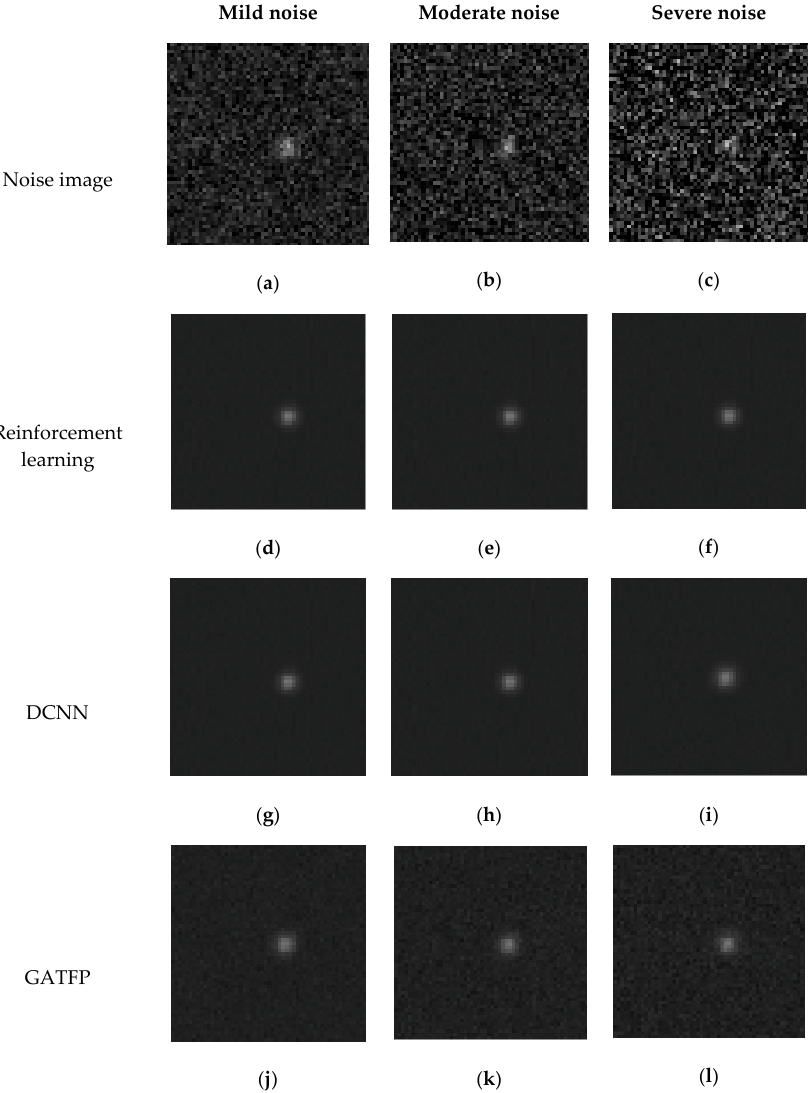
Figure 5. Restoration results on the noise images produced based on the same ground truth (Figure 1): ( a ) noise image with mild noise, ( b ) noise image with moderate noise, ( c ) noise image with severe noise, ( d ) denoising result using reinforcement learning on mild noise, ( e ) denoising result using reinforcement learning on moderate noise, ( f ) denoising result using reinforcement learning on severe noise, ( g ) denoising result using DCNN [45] on mild noise, ( h ) denoising result using DCNN [45] on moderate noise, ( i ) denoising result using DCNN [45] on severe noise, ( j ) denoising result using GATFP [6] on mild noise, ( k ) denoising result using GATFP [6] on moderate noise, ( l ) denoising result using GATFP [6] on severe noise.